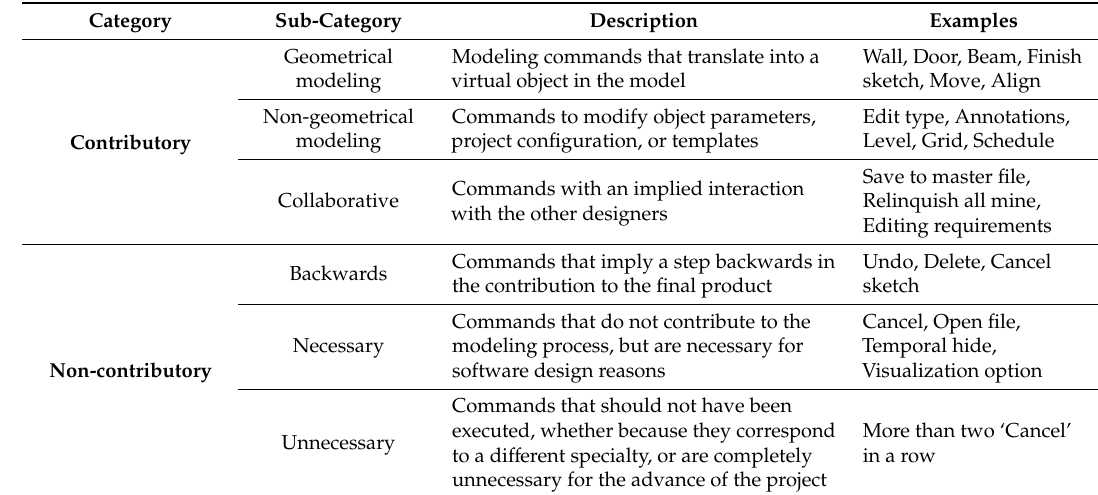
Table 1. Classification system for executed